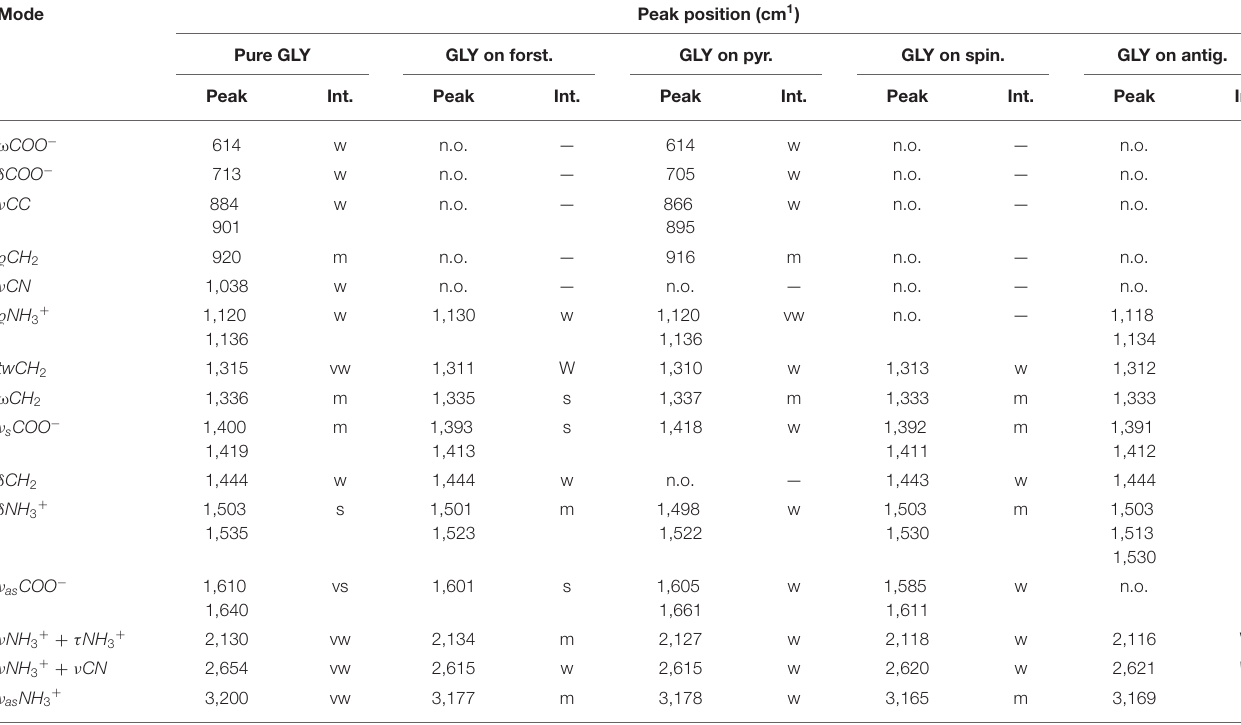
TABLE 3 | Band assignment for pure GLY and GLY adsorbed on minerals. Mode Peak position (cm 1 ) Pure GLY GLY on forst. GLY on pyr. GLY on spin. GLY on antig. Peak Int. Peak Int. Peak Int. Peak Int. Peak Int.